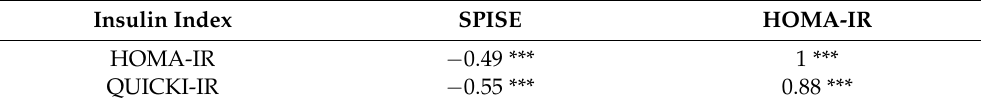
Table 3. Pearson product–moment correlation of SPISE and established insulin indexes at baseline. Insulin